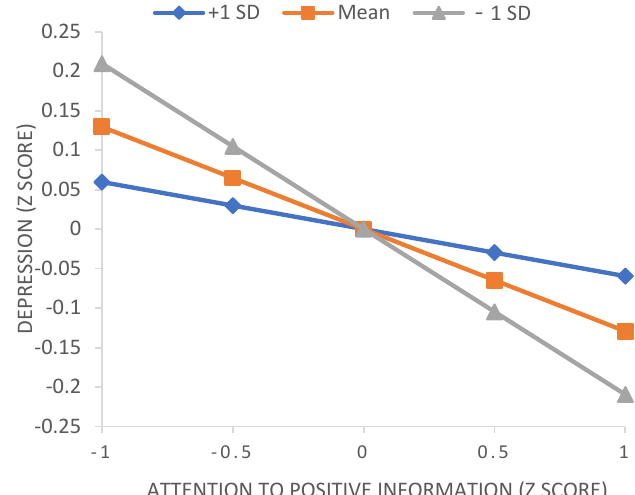
Figure 2. Depression predicted by attention to positive information moderated by socio-emotional skills. +1 SD, one standard deviation above the mean; −1 SD, one standard deviation below the mean.